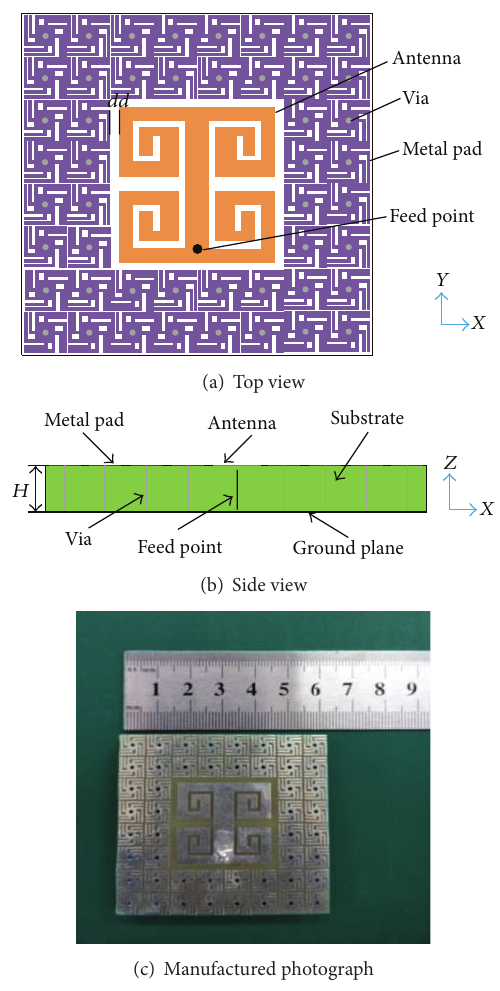
Figure 9: Configuration of a spiral slot patch antenna with EBG